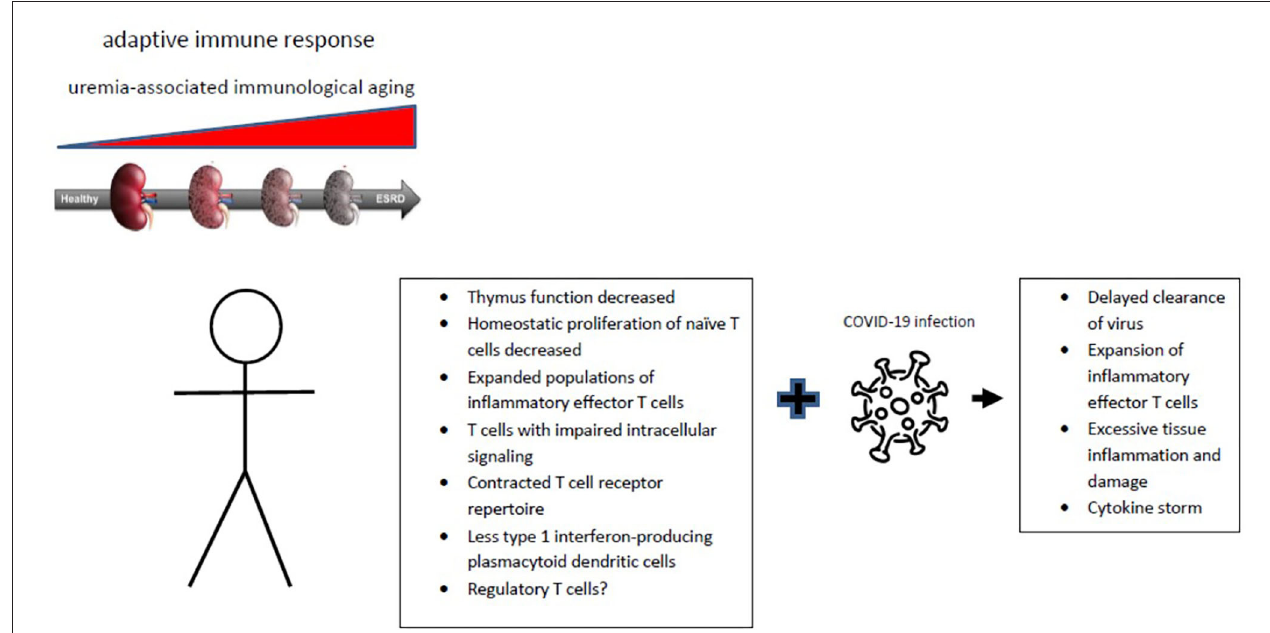
FIGURE 1 | Progression of chronic renal failure is associated with immunological aging affecting the adaptive immune system. The typical hall marks of immunological aging are given with an uncertain role for regulatory T cells. The changes of uremia-associated immunological aging can contribute to the substantially increased COVID-19 infection-associated morbidity and mortality of patients with chronic renal